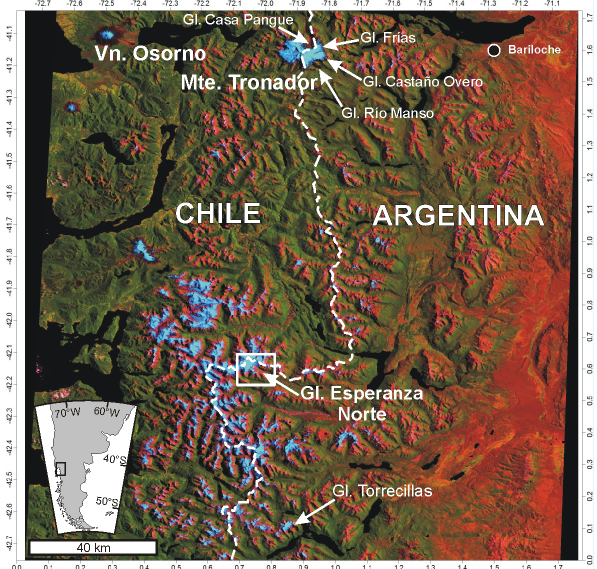
Fig. 1. Map showing the location of the study area and Glaciar Es- peranza Norte in the north Patagonian Andes of Argentina. Other glaciers discussed in the text are indicated. The background image is a composite (bands 541) RGB Landsat TM scene acquired in late February